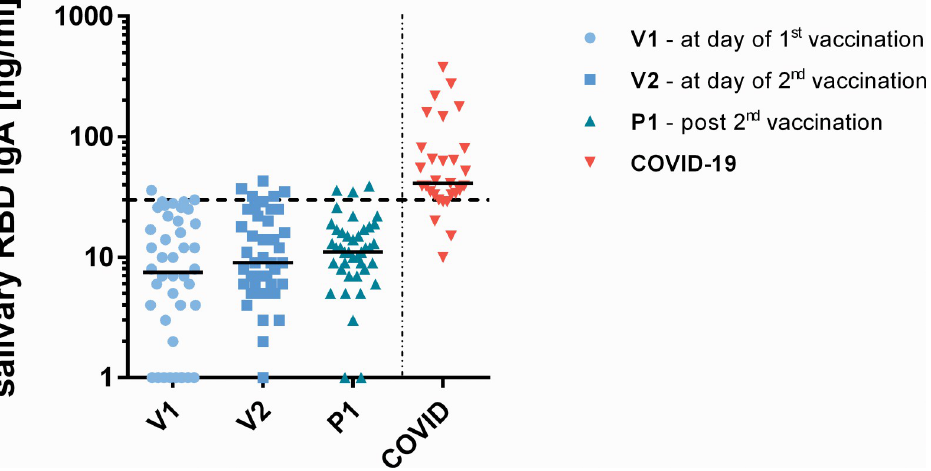
Fig 7. Salivary IgA specific to SARS-CoV-2 RBD in N = 40 individuals prior first (V1), three weeks after first (V2) and to weeks after second vaccination (P1) in comparison with COVID-19 patients (N = 31). The dotted line indicates the 95% interquartile range for